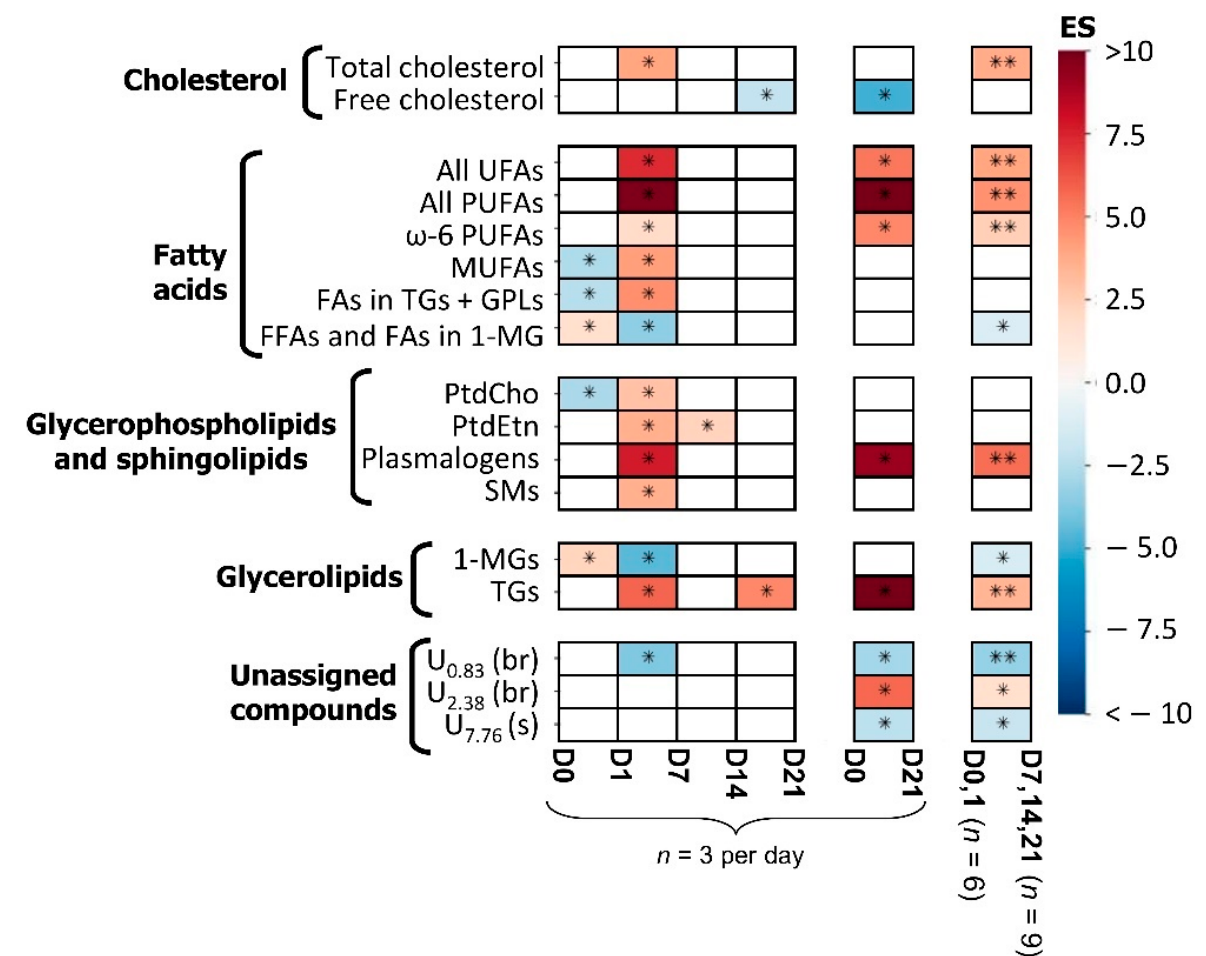
Figure 4. Heatmap showing statistically significant lipidic variations observed during osteogenic differentiation of hAMSCs, selected by spectra visual assessment and coloured according to the effect size (ES) values, from minimum (dark blue) to maximum (dark red). Rows correspond to lipidic species/classes and columns allow for comparisons between consecutive analysed timepoints between extreme days (days 0 vs. 21) and between classes (days 0 and 1 vs. 7, 14, and 21). Abbreviations as defined in Figure 2. Di: day i; U δ : unassigned signal at chemical shift δ ; *: Wilcoxon Rank-sum p -value < 0.05; and **: Wilcoxon Rank-sum p -value < 0.01.